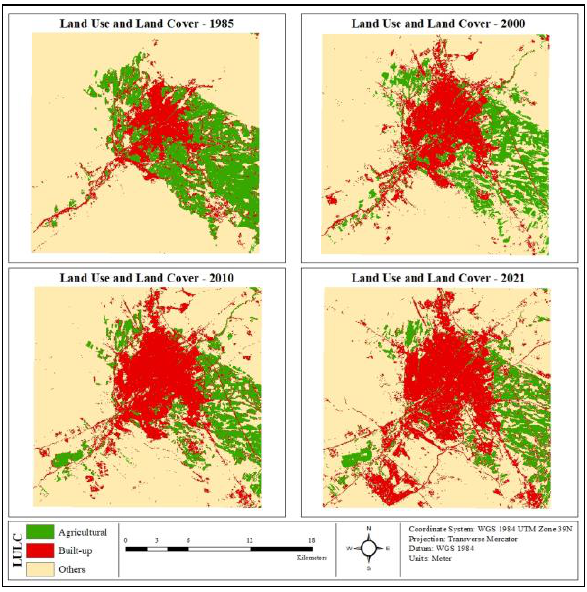
Figure 2 . Land use land cover in Qom, Iran from 1985 to 2021